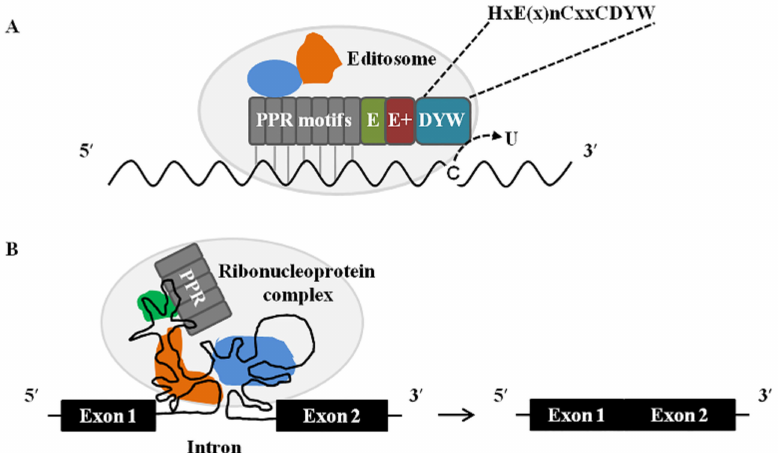
Figure 2. Proposed model for the molecular mechanisms of PPR proteins in plant organellar RNA editing and RNA splicing. ( A ) A model for the involvement of a DYW-type PPR protein in C-to-U RNA editing. C-to-U RNA editing in plant mitochondria and chloroplasts is carried out by an editosome composed of proteins and RNA. PPR motifs bind to its target RNA according to the PPR-RNA recognition code [123], which can be influenced by other proteins (shown in blue and orange). The DYW domain containing a cytidine deaminase signature (listed as HxE(x)nCxxC) converts the target cytidine (C) to uridine (U). ( B ) A model for the involvement of a P-class PPR protein in intron splicing. The splicing of introns in plant mitochondria and chloroplasts is proposed to be mediated by a ribonucleoprotein complex, where PPR proteins and other RNA-binding proteins (shown in green, blue, and orange) bind to their target intron to help its folding and stabilizing in an active